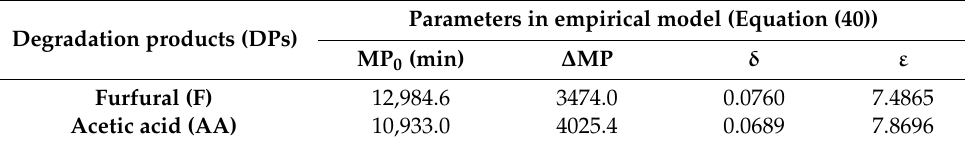
Table 3. The parameters in the empirical model (Equation (25)) for predicting the formation of degradations (F or AA) during EACO